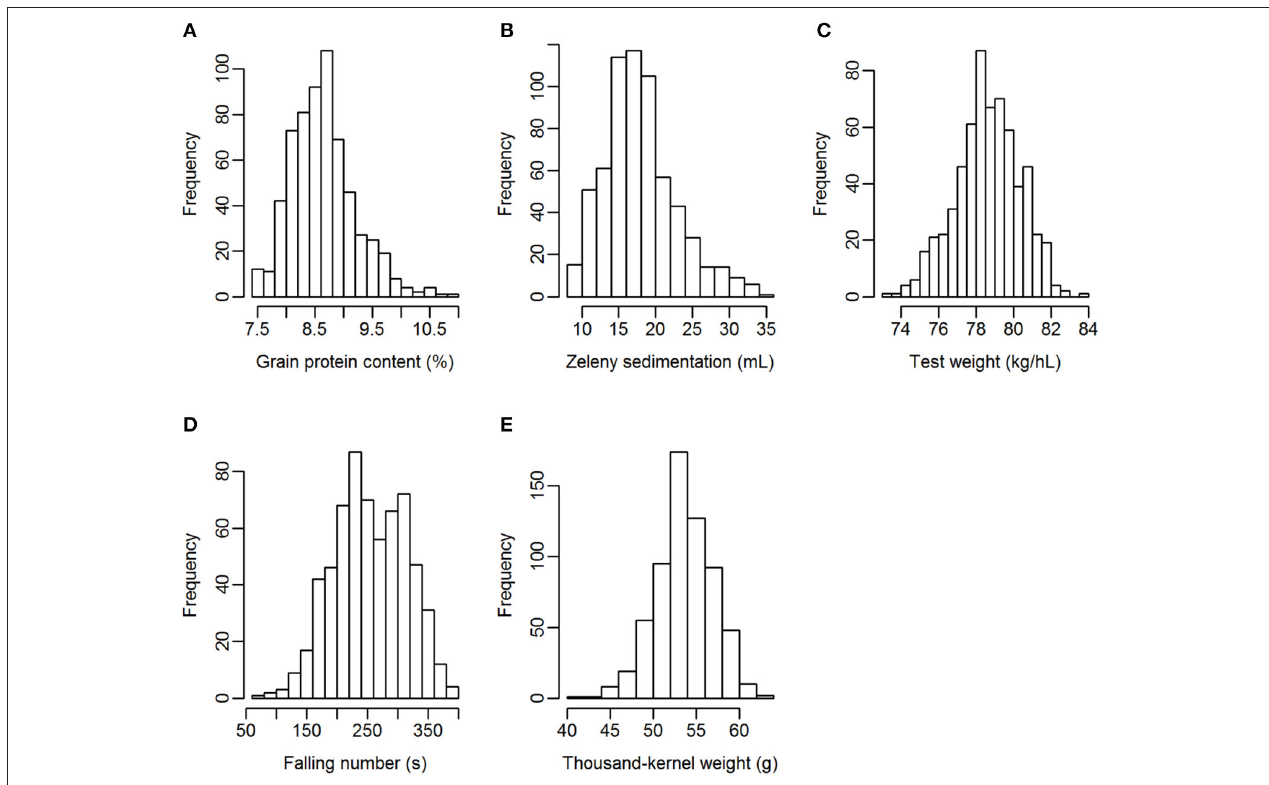
FIGURE 1 | Distribution of the phenotypes. (A) Grain protein content, (B) Zeleny sedimentation, (C) test weight, (D) falling number, (E) thousand-kernel weight.